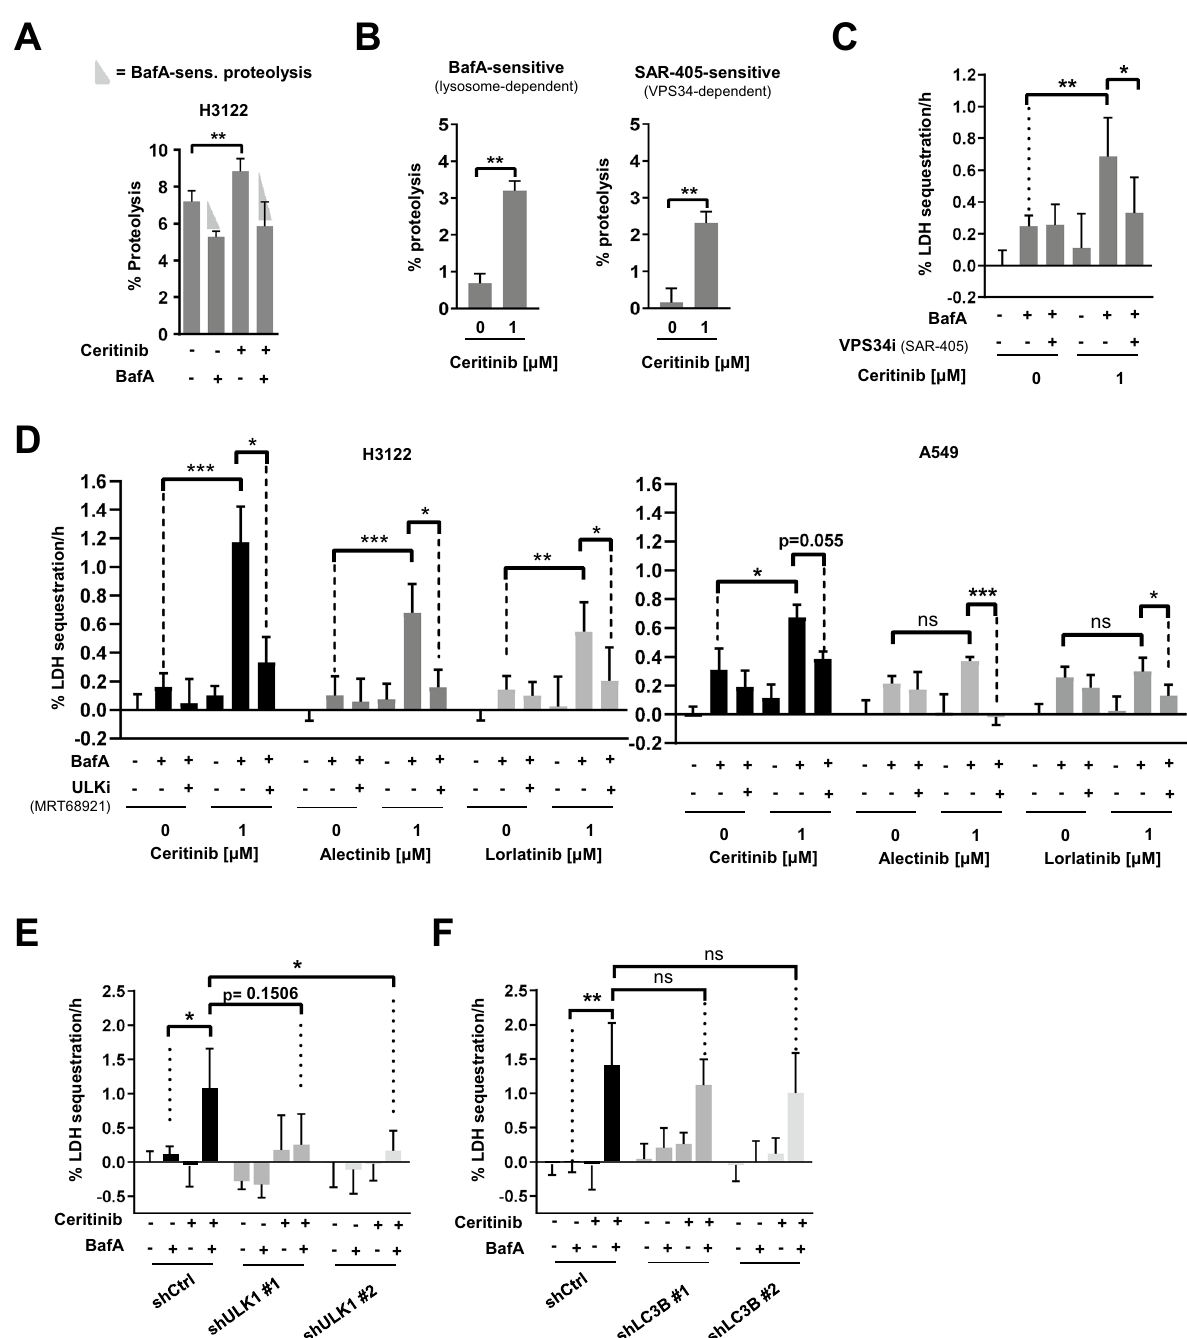
Figure 2. Ceritinib triggers ULK1- and VPS34-dependent autophagy ( A ) Bar plot represents percent proteolysis of H3122 cells after treatment with DMSO or Ceritinib for 24 h in the presence or absence of BafA during the last 5 h (n = 3). ( B ) Quantification of BafA-sensitive and SAR-405-sensitive proteolysis in H3122 cells after treatment with 1 µM Ceritinib for 24 h (n = 3). Percent proteolysis was determined and calculated as described in the methods section. ( C ) H3122 cells were treated with DMSO or 1 µM Ceritinib (24 h) ± BafA and ± SAR405 (during the last 3 h) before LDH sequestration was determined (n = 3). ( D ) H3122 and A549 cells were treated with DMSO or 1 µM Ceritinib/Alectinib/Lorlatinib (24 h) ± BafA and ± MRT68921 (during the last 3 h) before LDH sequestration was determined (n = 3). ( E ) H3122 control (shCtrl) and two ULK1 knock down (shULK1#1 and shULK1#2) cell lines were subjected to LDH sequestration assay after 18 h of Ceritinib treatment. BafA was added during the last 3 h (n = 3). ( F ) Experiment as in E, but with H3122 shCtrl, shLC3B#1 and shLC3B#2 cells (n = 3). Mann–Whitney U was applied to compare two groups; * p < 0.05, ** p < 0.01, *** p <